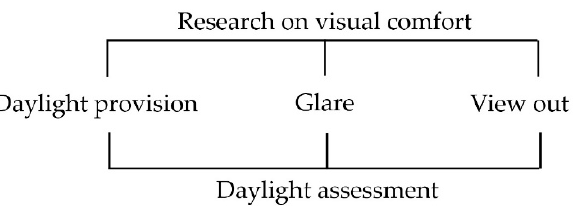
Figure 1. Research on visual comfort focuses mainly on three quality components. Daylight assessments are mainly conducted on the same components.